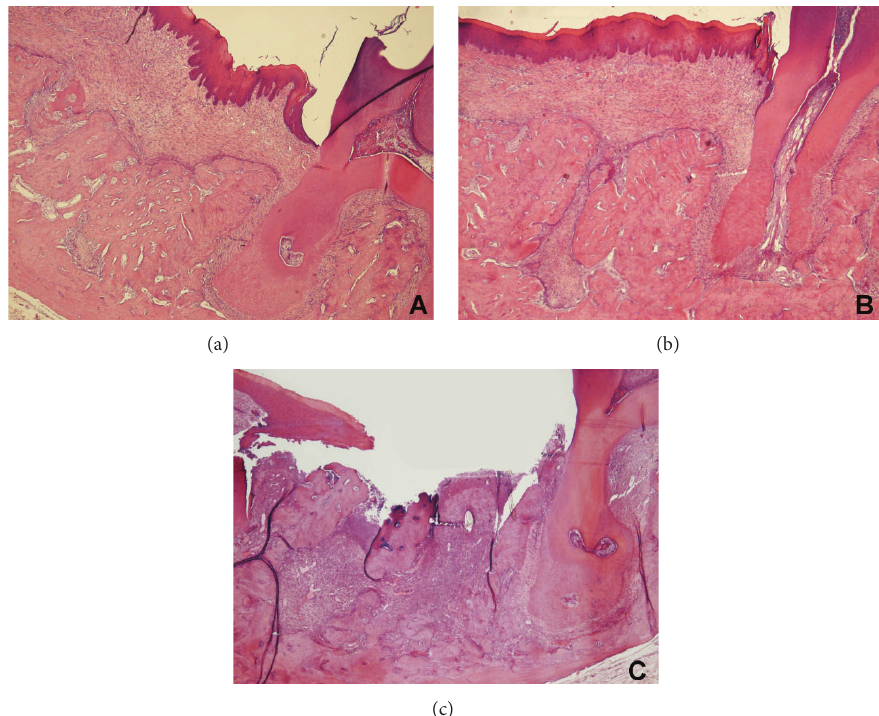
Figure 3: Histological sections showing the region of the second molar 14 days after extraction in male Sprague-Dawley rat. (a) Control rat with no treatment, (b) BP treated with coverage, and (c) BP treated without coverage. Note necrotic tissue.